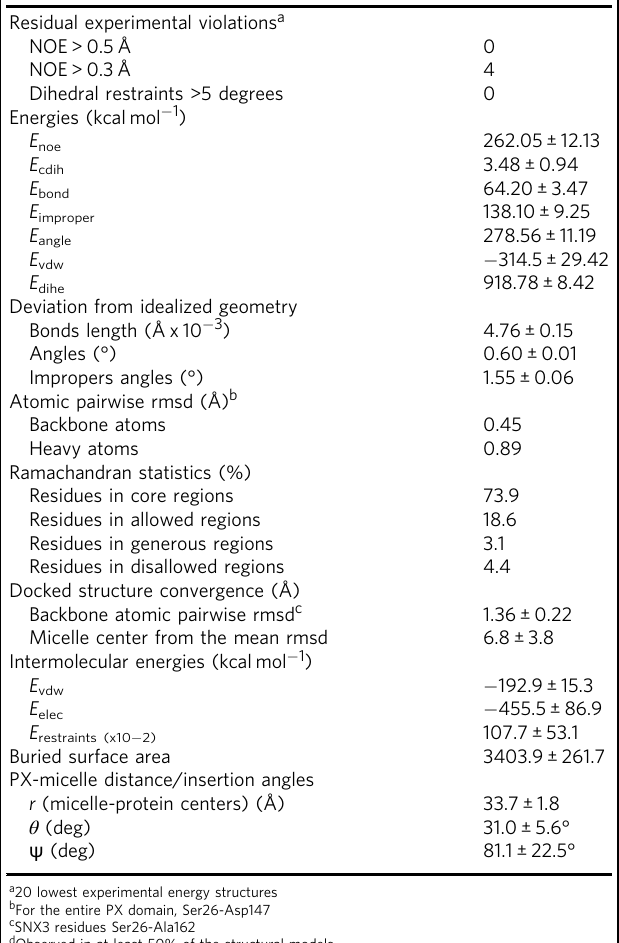
Table 2 Structural statistics for the solution structures of SNX3 and its micelle